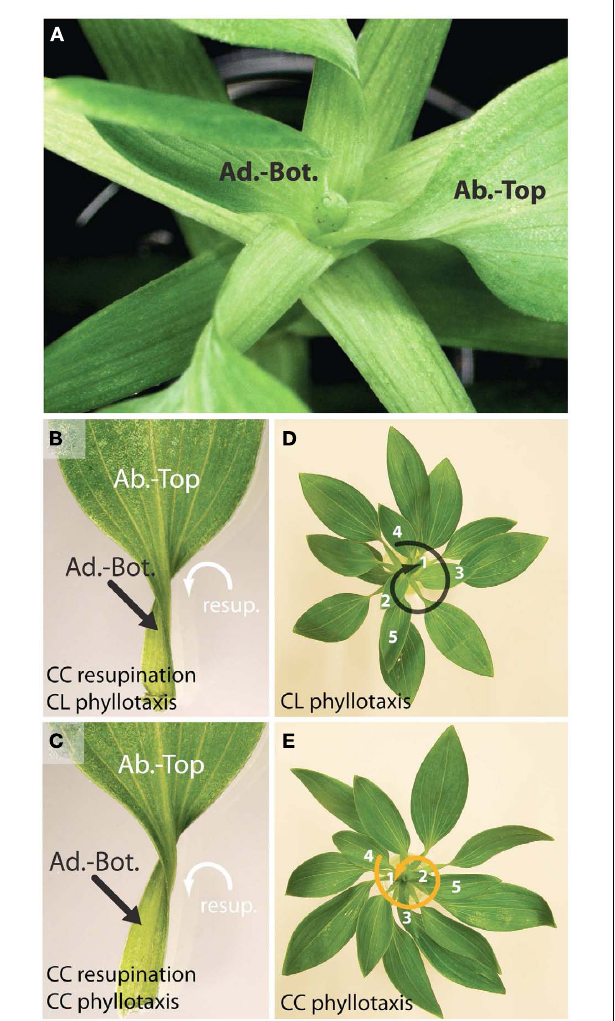
FIGURE 1 |The direction of resupination is invariant in A. psittacina. (A) Resupination occurs late in leaf development in A. psittacina . Note that the leaf in which the adaxial-bottom side is marked is in the process of inverting.The next leaf in the series, in which the abaxial-top side is marked, has completed its inversion.The leaves that are marked will continue to develop, accentuating the petiole region and growing in size. (B,C) Leaves from clockwise [ (B) , CL] and counter-clockwise [ (C) , CC] plants, showing that the direction of resupination is invariant. CC turning of the leaf (white arrow) is in respect to the perspective shown, looking down the petiole toward the leaf tip. (D,E) Plants exhibiting CL (D) and CC (E) phyllotaxy. Phyllotactic direction is determined by traversing up the spiral toward the apex, moving from older to younger leaves. As mentioned in the text, there is no statistical deviation in the frequency by which each phyllotactic direction occurs from a 50:50 ratio. Black and orange denote CL and CC phyllotaxis throughout the